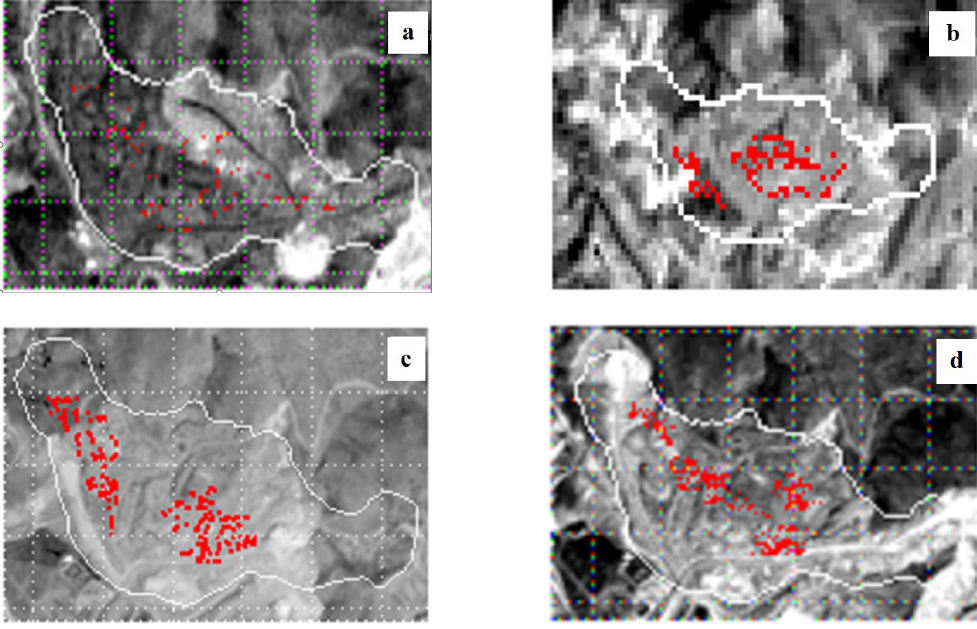
Figure 10. Segmented Aster ( a ), Hyperion ( b ), Sentinel-2A ( c ) and Landsat 8-OLI ( d ) images (the red dots are the pixels got the value of one after image segmentation using binary fit